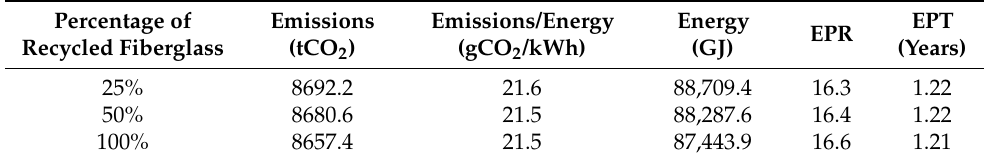
Table 9. CO 2 emissions and energy consumption for the project considering different levels of recycled fiberglass.